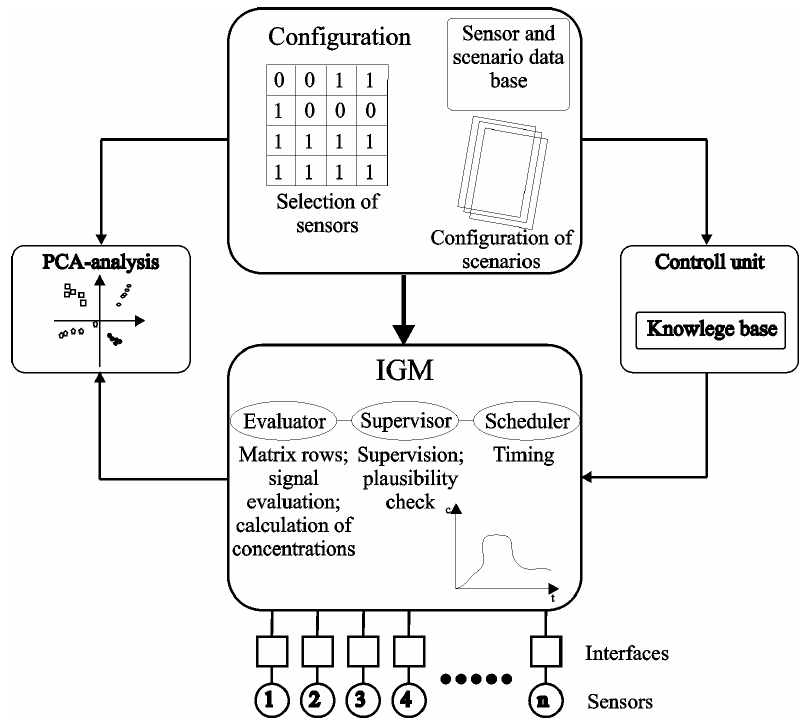
, NH , H , CO and C H OH. 4 3 2 2 5